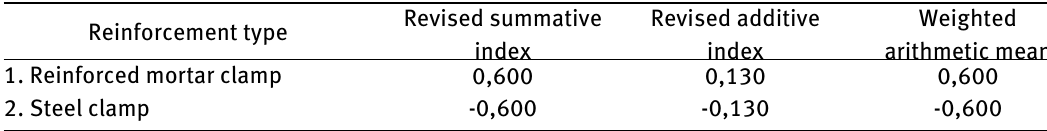
Table 11: Synthetic evaluation summary (standarization method encoding) (own studies) Reinforcement type